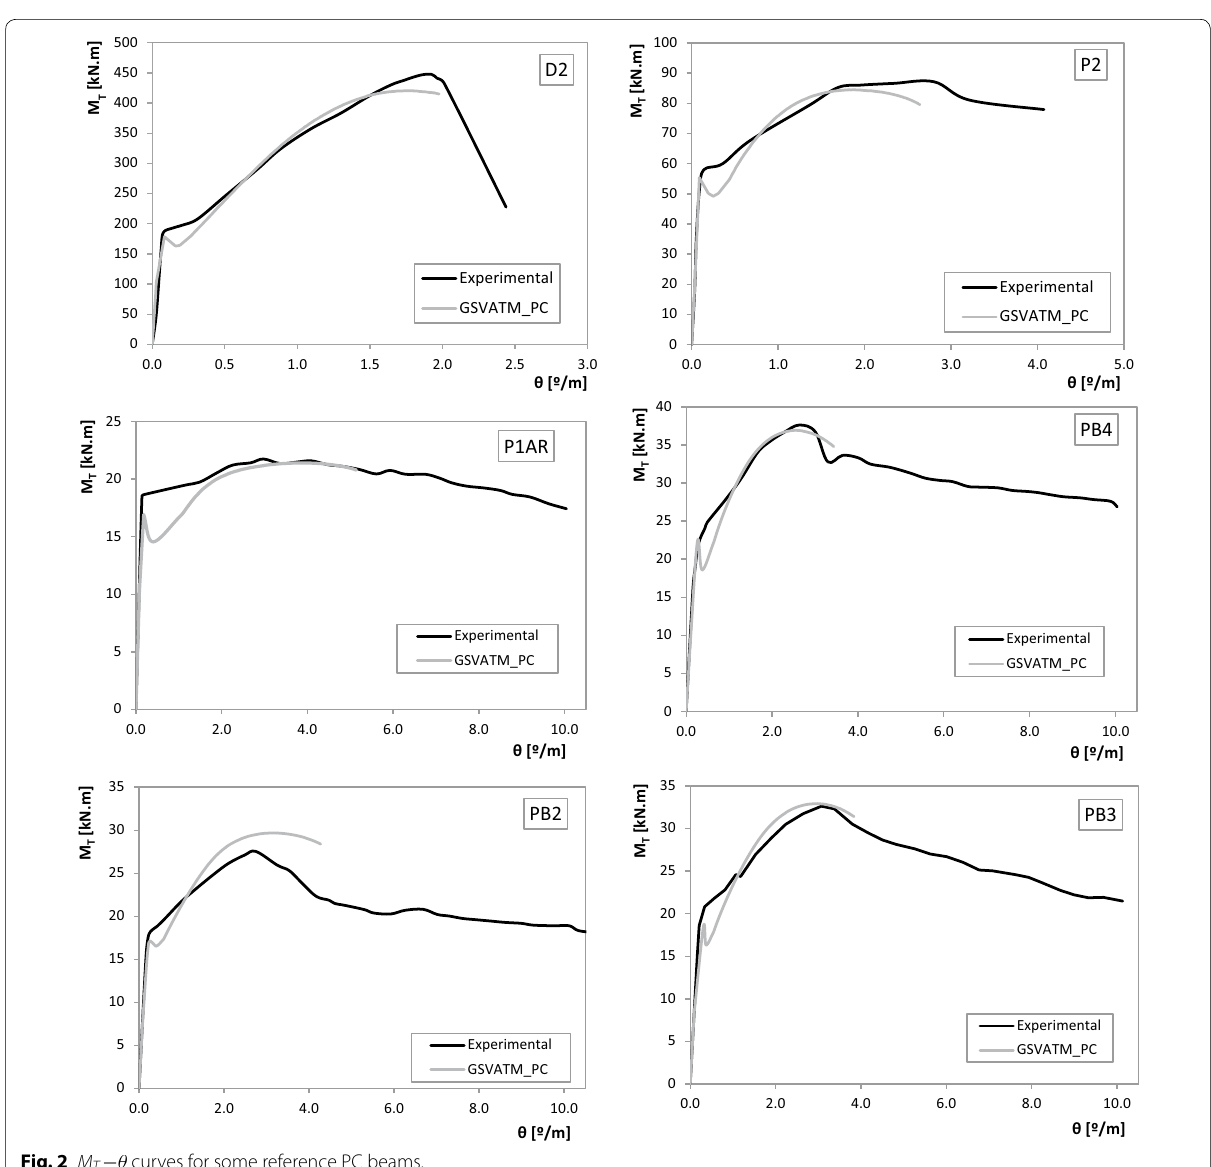
Fig. 2 M T − θ curves for some reference PC